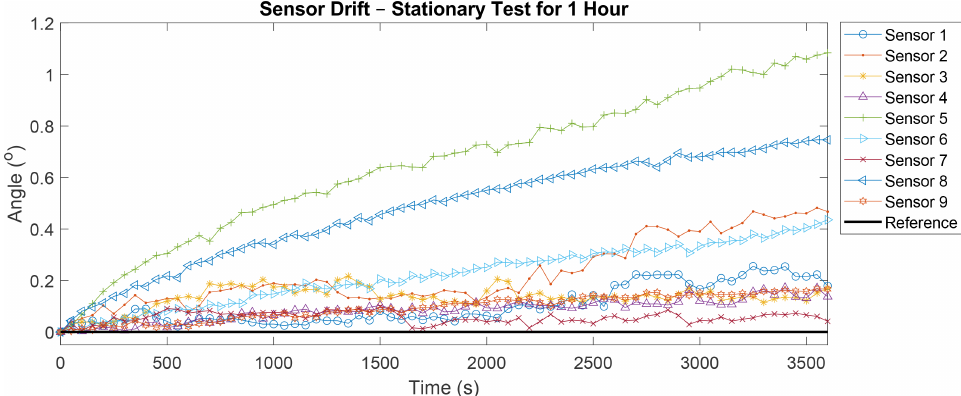
Figure 6. Sensor drift of the individual IMUs while stationary over a one-hour period fused with the Kalman filter without the magnetometer plotted alongside